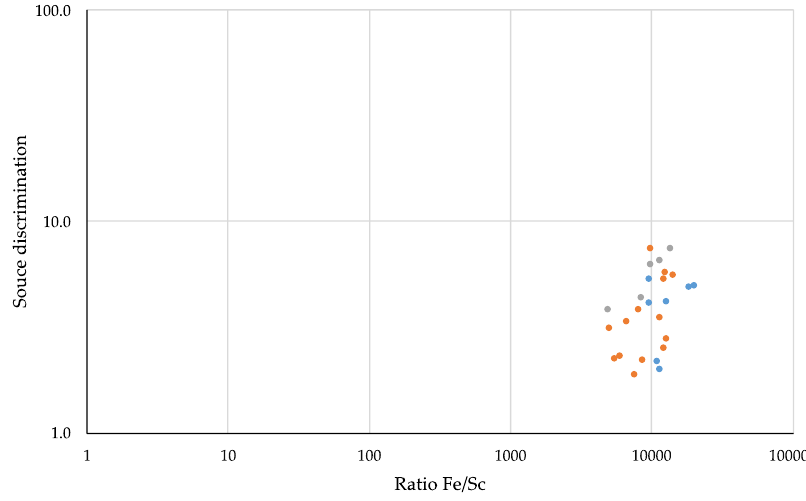
Figure 3. Multiple regression analysis: plot of the discrimination factor (source discrimination) versus Fe/Sc abundance ratio (blue: PM 10 ; orange: PM 2.5 ; grey: PM 1 ).